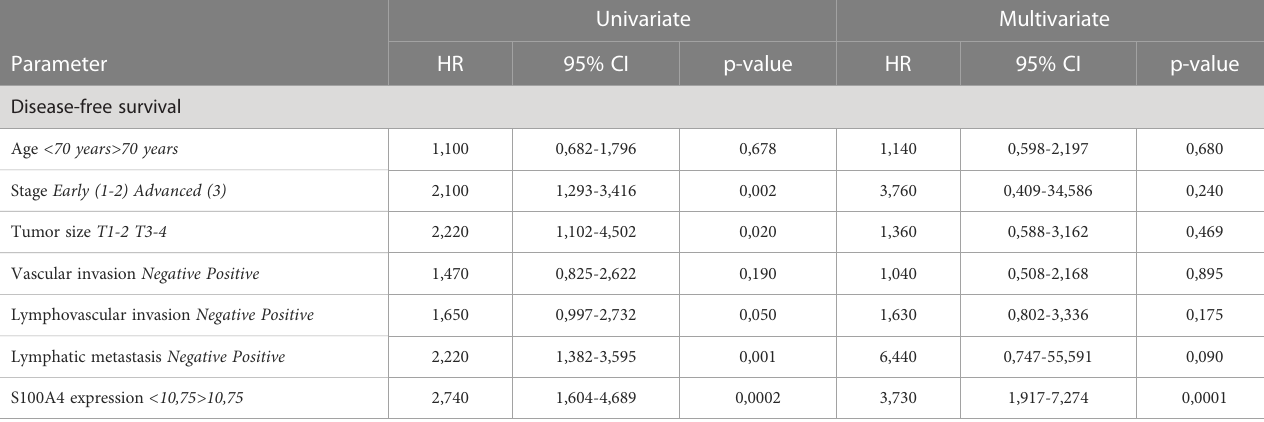
TABLE 1 The prognostic signi fi cance of S100A4 mRNA levels for disease-free survival in patients with CRC revealed by univariate and multivariate COX analysis.